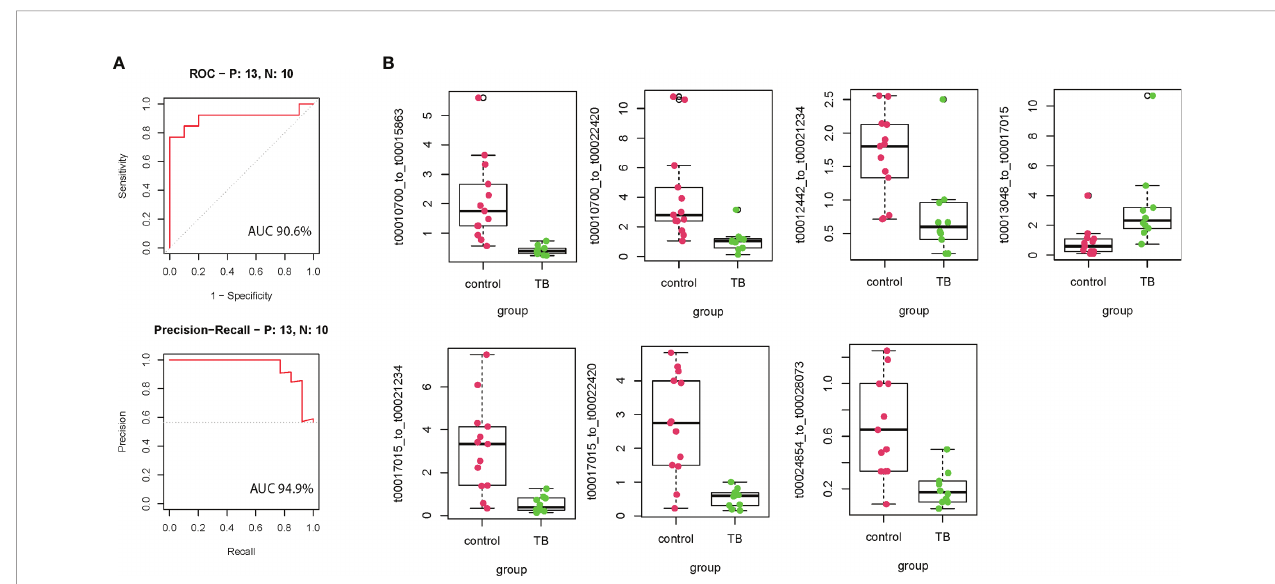
FIGURE 2 | The performance of the training model in the discovery cohort. (A) Seven model selected mtRNA expression levels in the discovery cohort. (B) ROC curve and PR curve of the diagnostic prediction model with mtRNA markers in the discovery cohort; All box plots are statistical signi fi cant, p